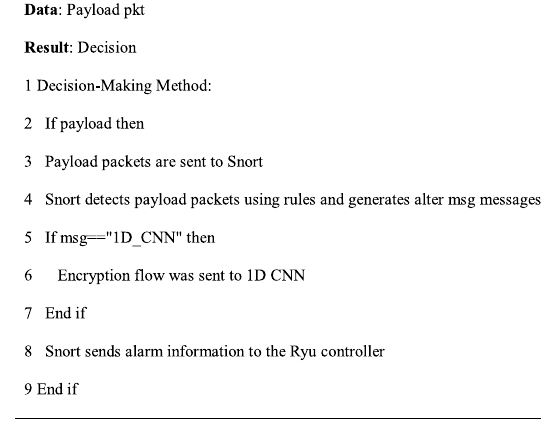
Algorithm 1 . Connection Selection Engine